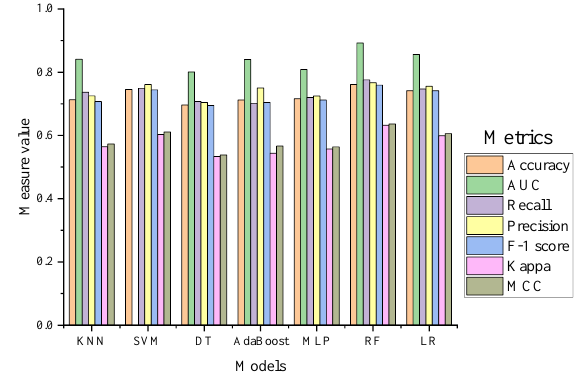
Fig. 2. MLAs performance with a 10-fold cross-validation training